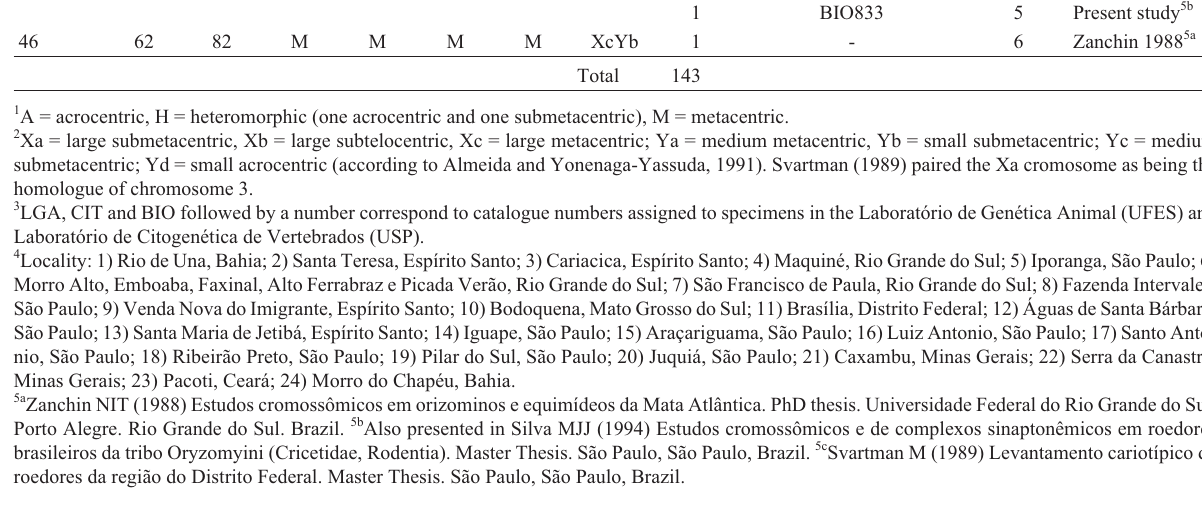
5a Zanchin NIT (1988) Estudos cromossômicos em orizominos e equimídeos da Mata Atlântica. PhD thesis. Universidade Federal do Rio Grande do Sul. Porto Alegre. Rio Grande do Sul. Brazil. 5b Also presented in Silva MJJ (1994) Estudos cromossômicos e de complexos sinaptonêmicos em roedores brasileiros da tribo Oryzomyini (Cricetidae, Rodentia). Master Thesis. São Paulo, São Paulo, Brazil. 5c Svartman M (1989) Levantamento cariotípico de roedores da região do Distrito Federal. Master Thesis. São Paulo, São Paulo,